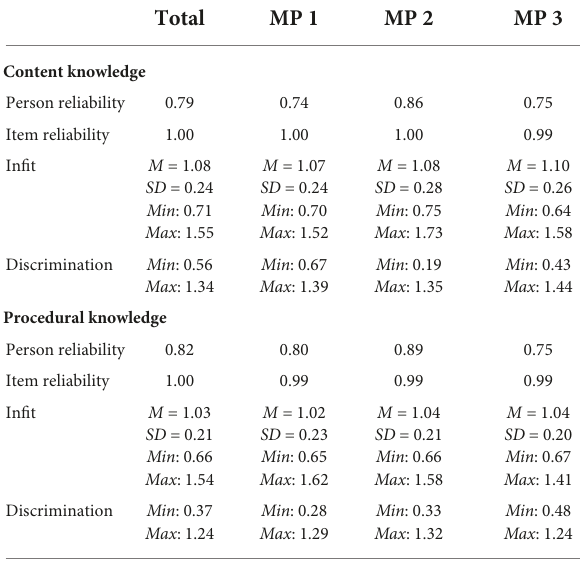
TABLE 2 Comparison of person parameters (measurement points 1 and 3) t -test for independent